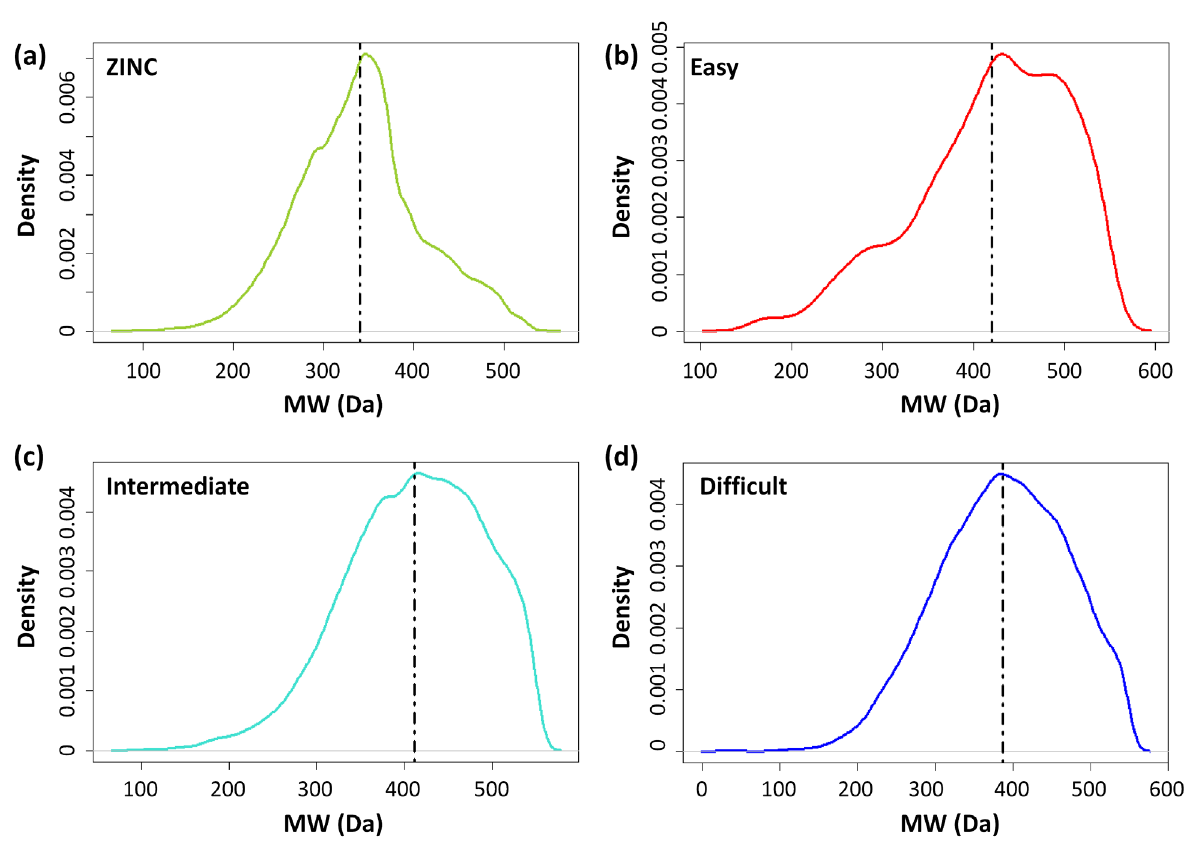
Figure 1. Molecular weight ranges. Density plots report the molecular weight (Da) distributions of compounds in all